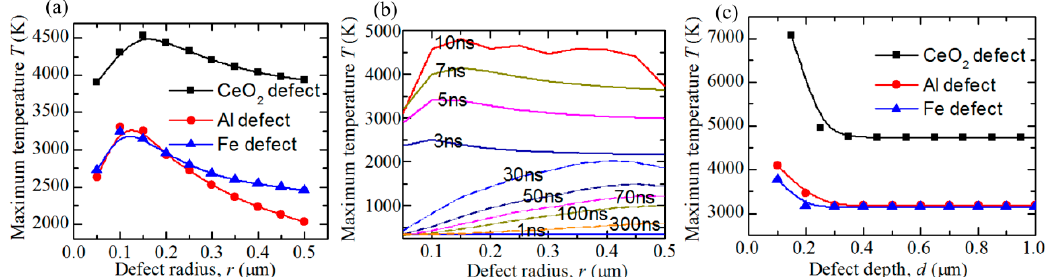
Figure 7. Evolutions of the maximum temperatures caused by various impurity defects with respect to the defect radius ( a ) and depth ( c ) during the laser loading period of 10 ns. ( b ) The dependence of maximum temperature on defect radius for CeO 2 defects under various laser loading times.